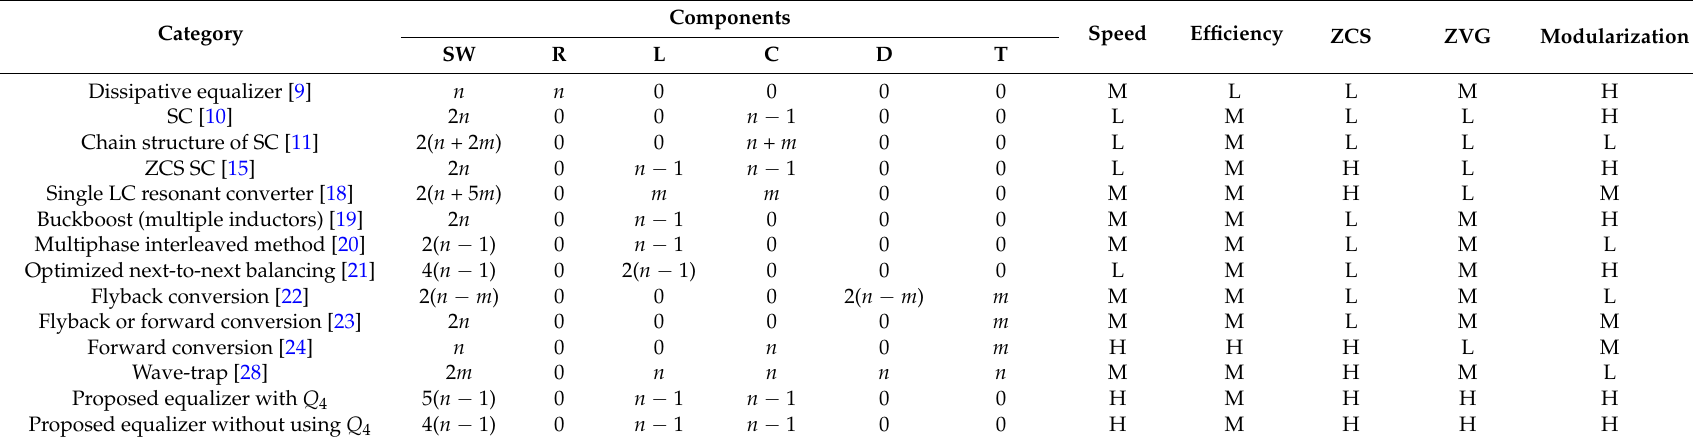
Table 1. Comparison of several battery